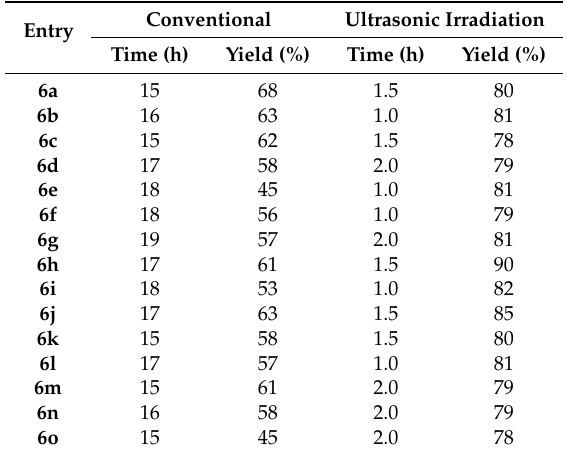
Table 1. Comparison of reaction kinetics of conventional and ultrasonic irradiation methods for the synthesized compounds 6a – o .